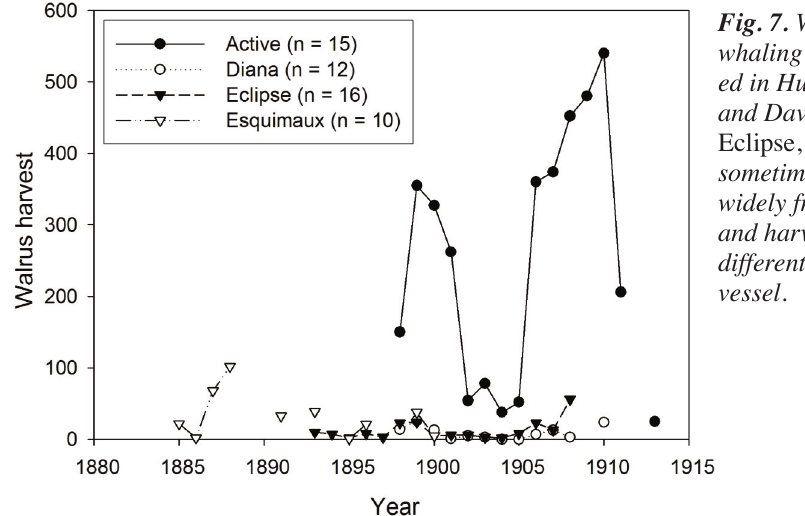
Fig. 7. Walrus catches by whaling vessels that hunt- ed in Hudson Bay ( Active ) and Davis Strait ( Diana, Eclipse, Esquimaux ) sometimes fluctuated widely from year to year and harvest patterns were different from vessel to